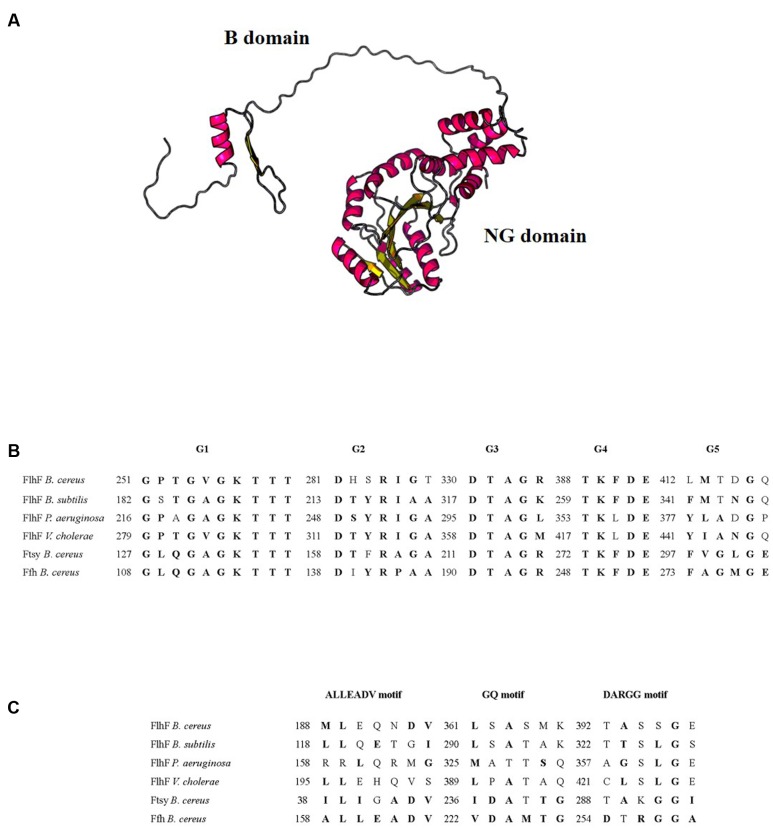
In silico analysis of B. cereus FlhF.
(A) Model of the three-dimensional structure of B. cereus FlhF. (B) Alignment of the amino acid sequences of the G1–G5 signatures of the G domain and their respective positions. (C) Alignment of the amino acid sequences of the ALLEADV, GQ and DARGG motifs and their respective positions. Conserved amino acids belonging to the same chemical class are marked in bold.